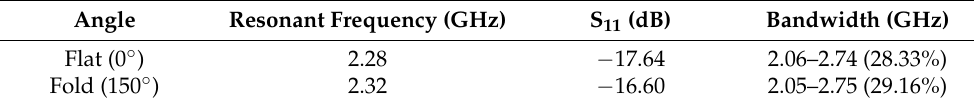
Figure 10. ( a ) Photograph. Measured characteristics under the flat and folding states. ( b ) Reflection coefficients. Radiation patterns: ( c ) x – z plane; ( d ) x – y plane. Table 3. Measured performance comparison of the antenna under the flat and folding states.